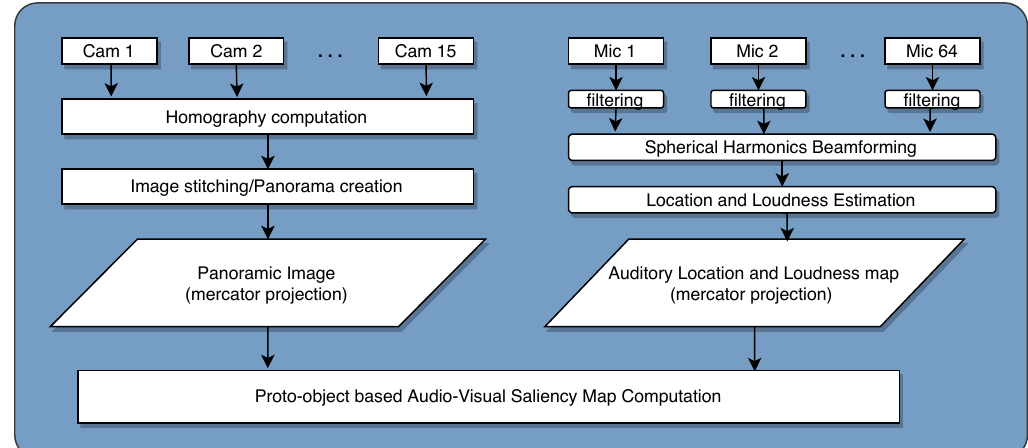
Figure 1. Overall architecture of the model: Video frames from 15 HD RGB cameras are stitched together to form a 360 ◦ panoramic view of the scene. Audio from 64 microphones are filtered and spherical harmonic beamforming (see Section 4 for details) is done to estimate the direction and loudness of different auditory sources in the scene. Both video stitching and audio beamforming are initially done on the surface of a unit sphere, later projected to 2D plane using mercator projection. The audio and video are in perfect spatiotemporal register, so there is a one-to-one correspondence between the visual object and auditory sound source in the scene. The 2D maps are then used to compute the Audio Visual Saliency Map as described in Figure 2.